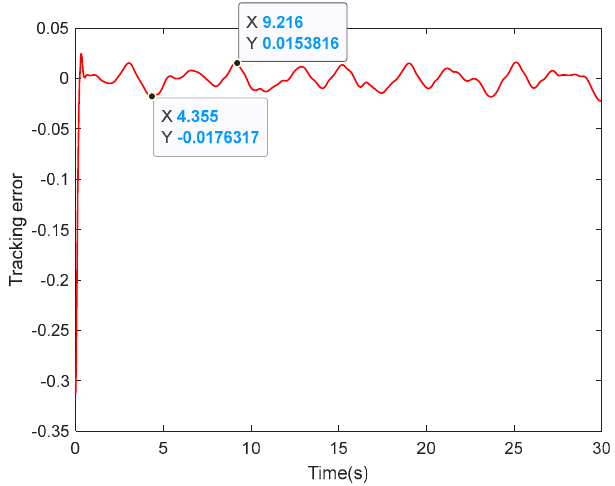
Figure 21. Tracking error of the DRNN-LADRC for the new radar servo system.